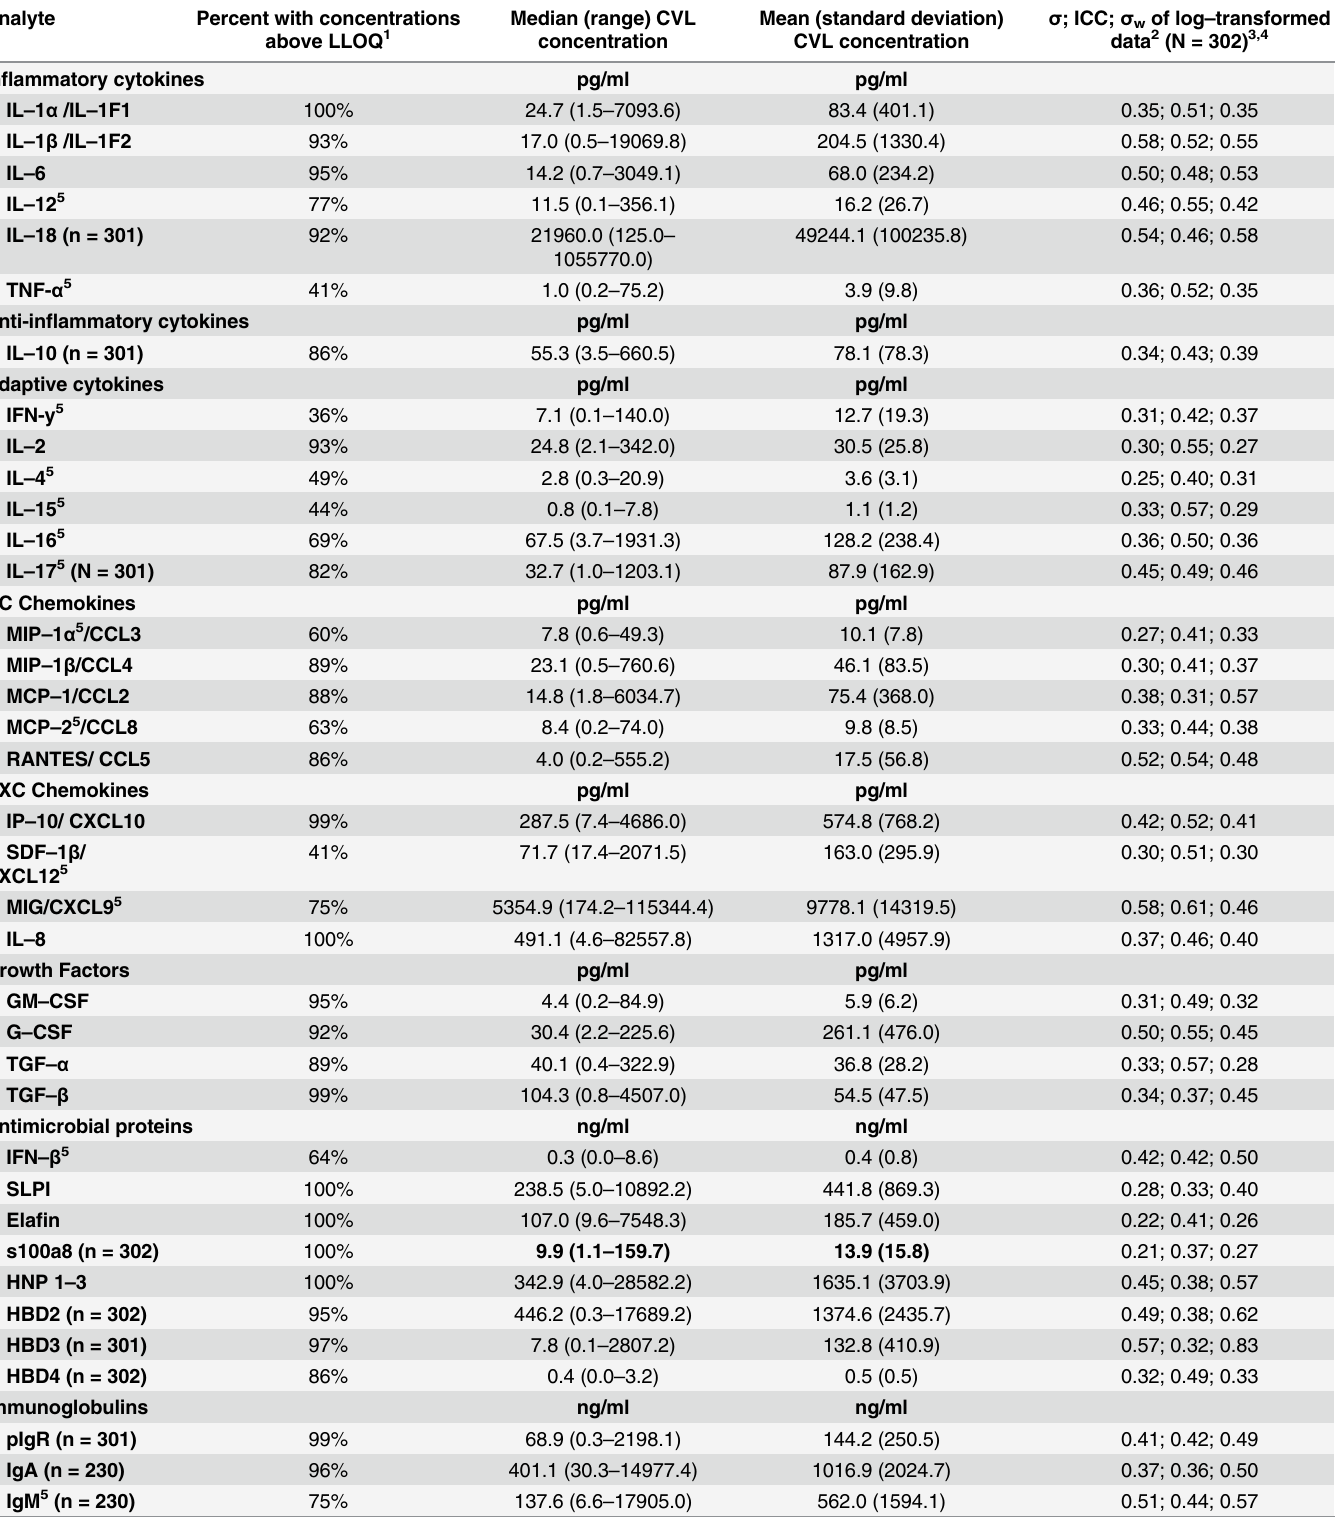
Table 2. The proportion of samples with analytes detected, median, mean and intra – class correlation coefficients (ICC) from 370 CVL samples.